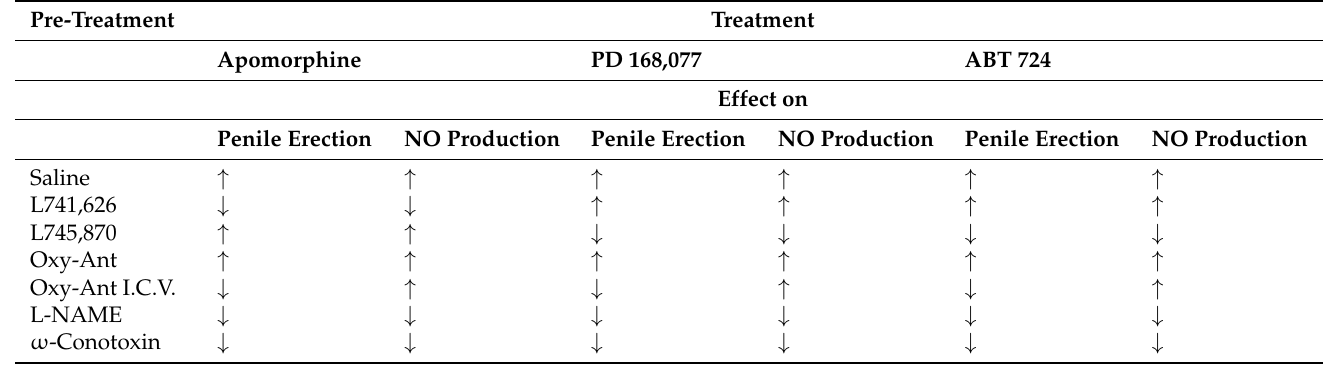
Table 6. D 2 and D 4 receptor agonists induce penile erection by activating nitric oxide synthase containing paraventricular oxytocinergic neurons that project to extrahypothalamic brain areas and the spinal